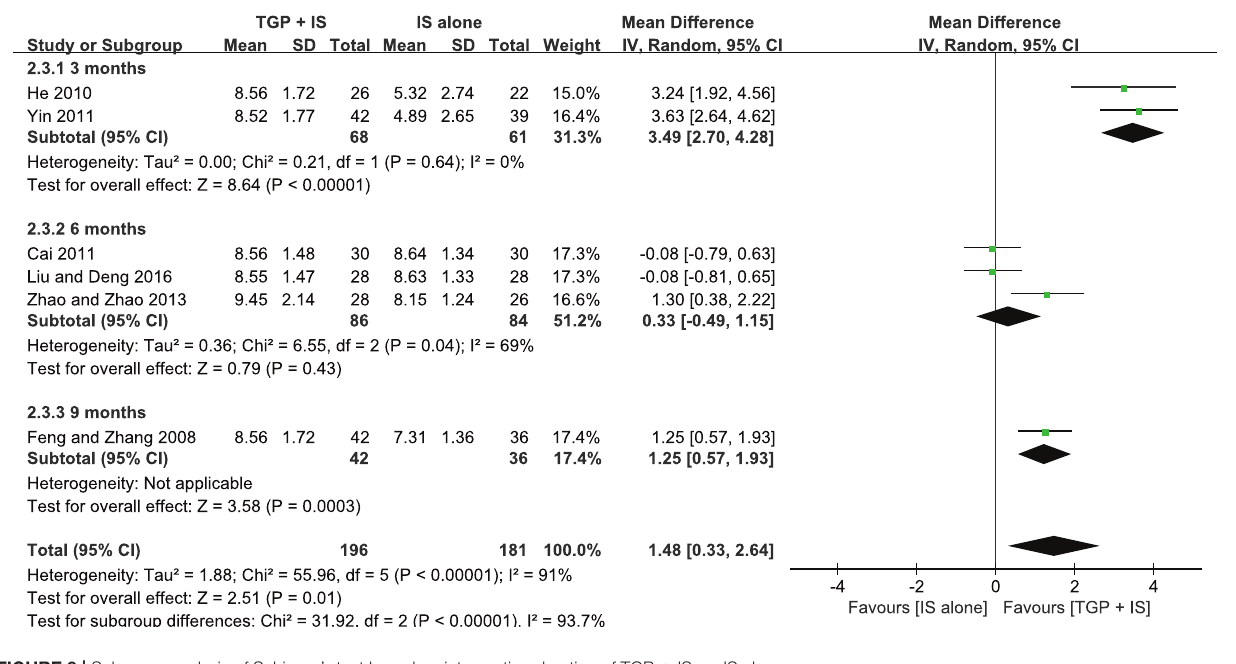
FIGURE 8 | Subgroup analysis of Schirmer’s test based on intervention duration of TGP + IS vs. IS